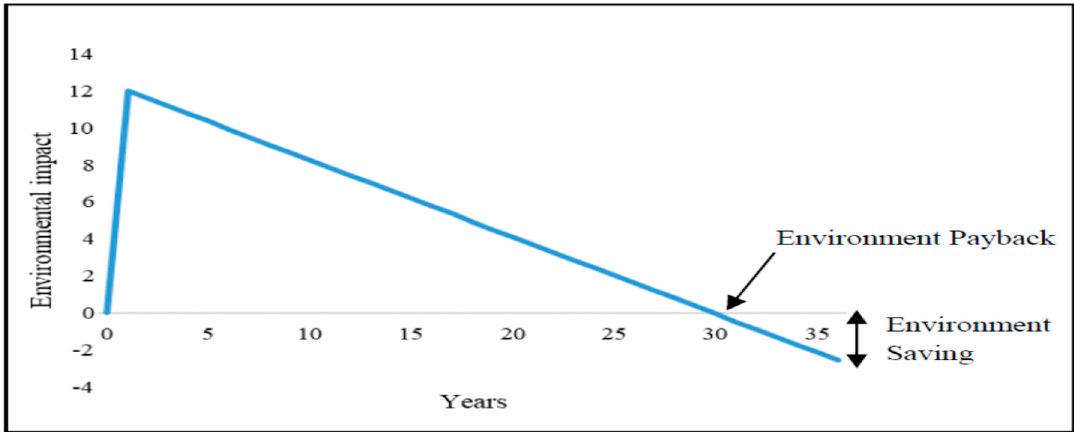
Figure 1. Environmental payback.